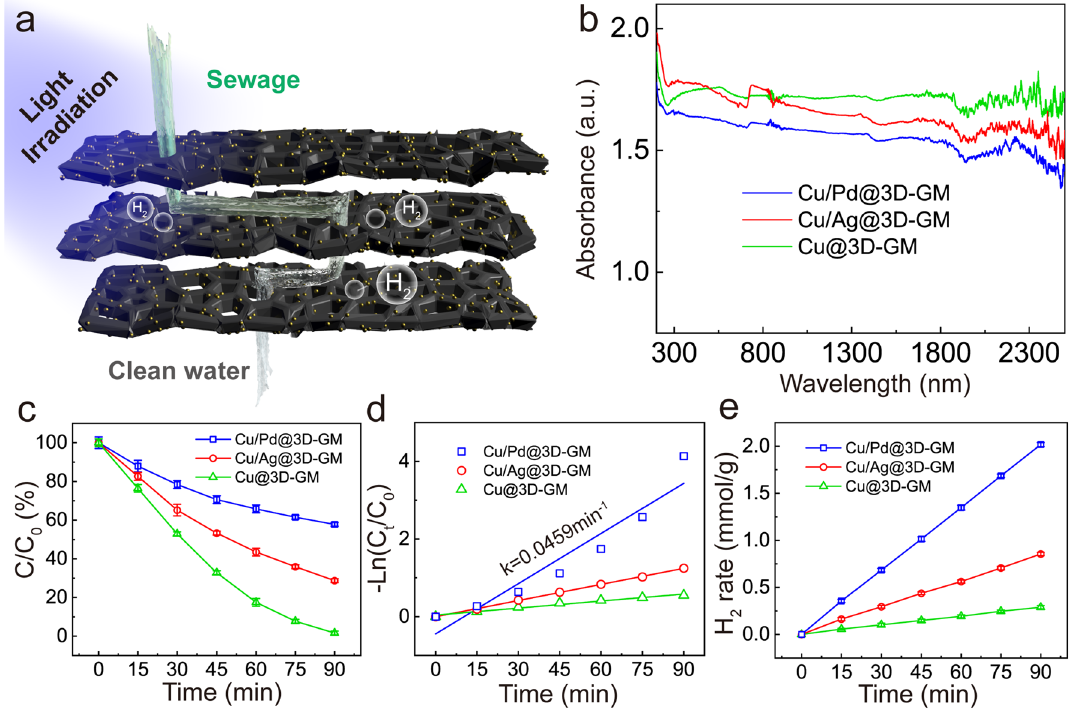
Fig. 3 a Schematic diagram of the photocatalysis process in a 3D‑GCM. b UV–Vis‑NIR absorption spectra, c, e photocatalytic degradation behaviors and